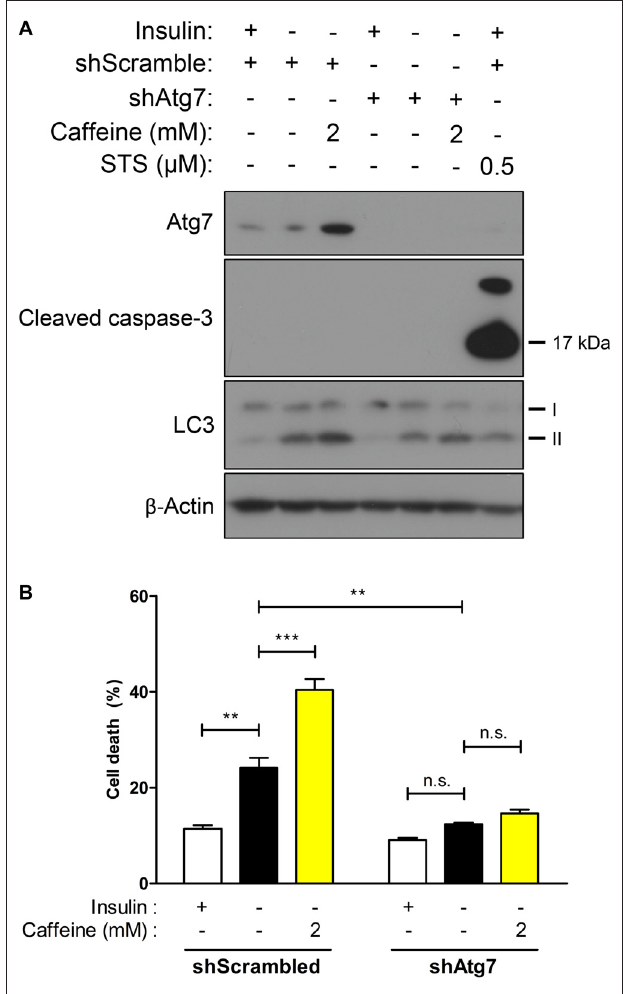
FIGURE 4 | Caffeine-induced potentiation of ACD is prevented in Atg7 knockdown HCN cells. (A,B) Effect of caffeine on autophagic activity was assessed in autophagy-defective HCN cells generated by shRNA-mediated suppression of Atg7 gene. (A) Western blot analysis of autophagy- and apoptosis-related proteins after caffeine treatment for 24 h in I( − ) HCN cells depleted of Atg7. Staurosporine (STS) was treated for 10 h before cell harvest to induce caspase-3 activation as a positive control of apoptosis. (B) Cell death analysis in caffeine-treated Atg7 knockdown HCN cells at 24 h. Each experiment set was performed in triplicate per experiment ( n = 4). The bars represent the mean ± SEM; ∗∗ p < 0.01, ∗∗∗ p < 0.001; n.s.,